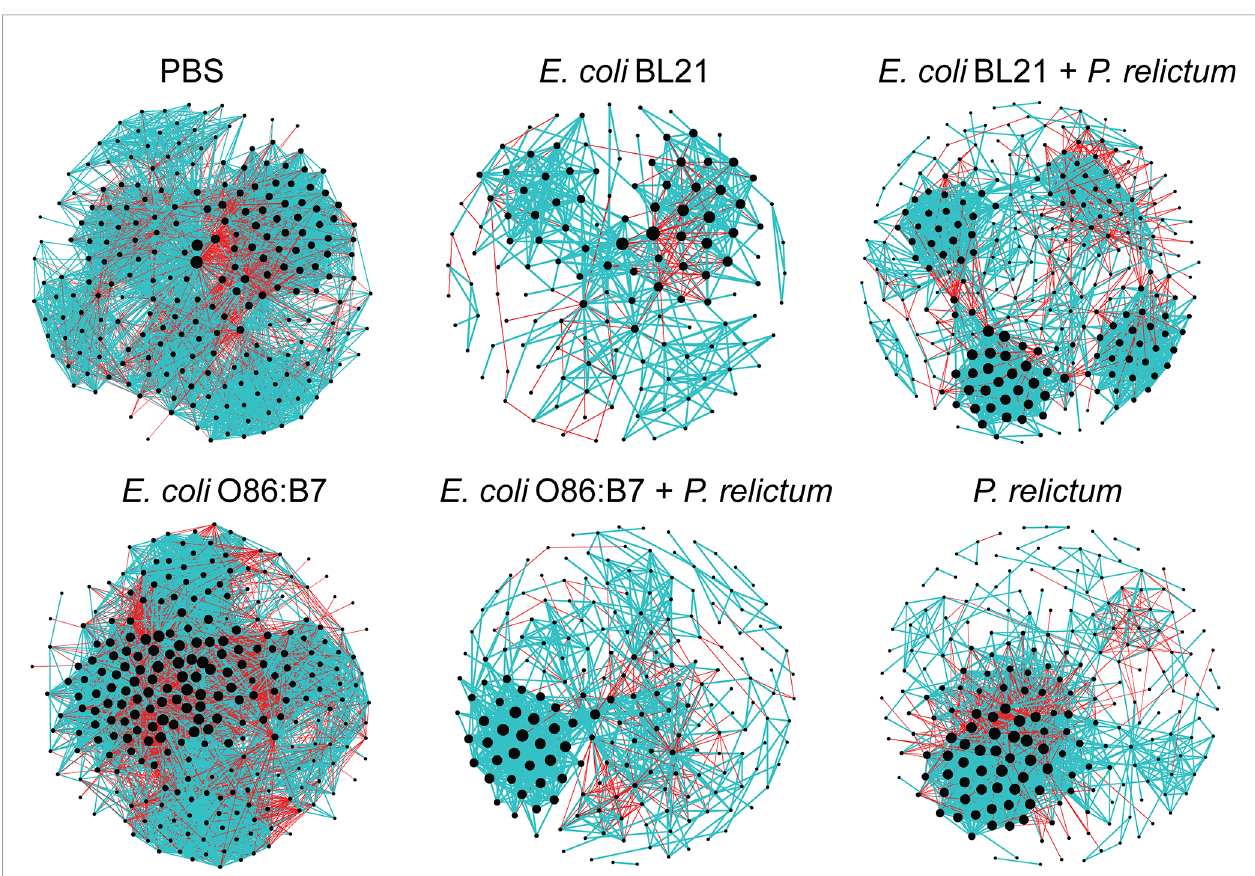
FIGURE 6 | Co-occurrence networks of C. quinquefasciatus microbiota in the different experimental groups. Bacterial co-occurrence networks were inferred from the microbiota of mosquitoes fed on control (PBS), vaccinated and/or infected birds. Nodes represent bacterial taxa and connecting edges stand for a co- occurrence correlation (SparCC > 0.75). Node sizes are proportional to the eigenvector centrality value. Edges representing positive or negative correlations were colored in blue and red, respectively. Only nodes with at least one connection are